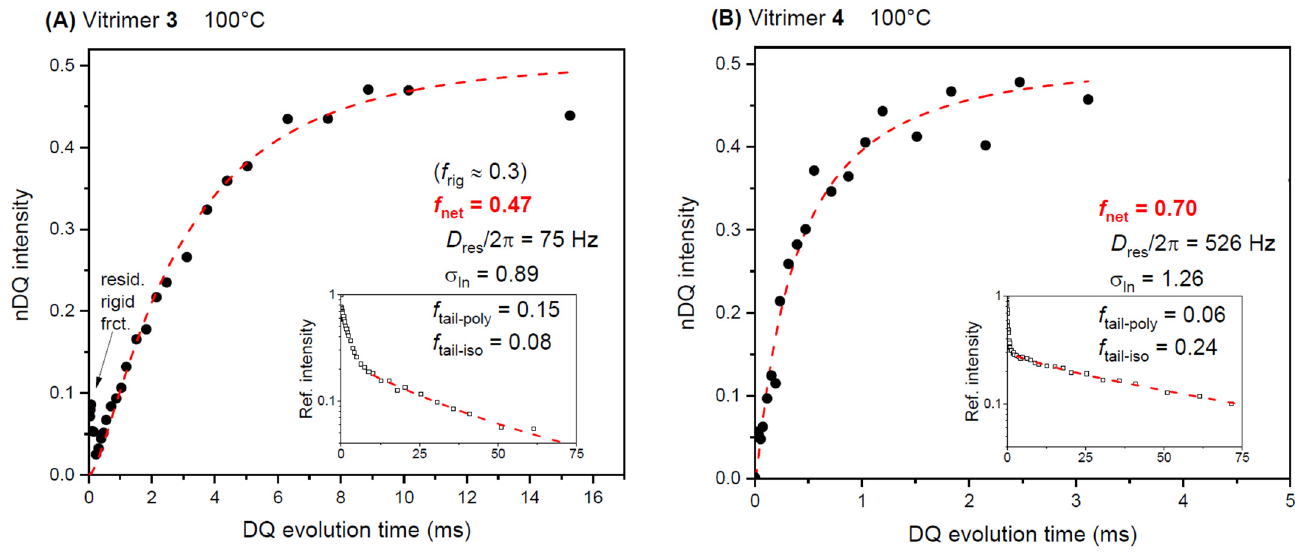
Figure 6. MQ NMR for characterization of the network structure of Vitrimers 3 ( A ) and 4 ( B ). The symbols are data and red dashed lines are the tits.